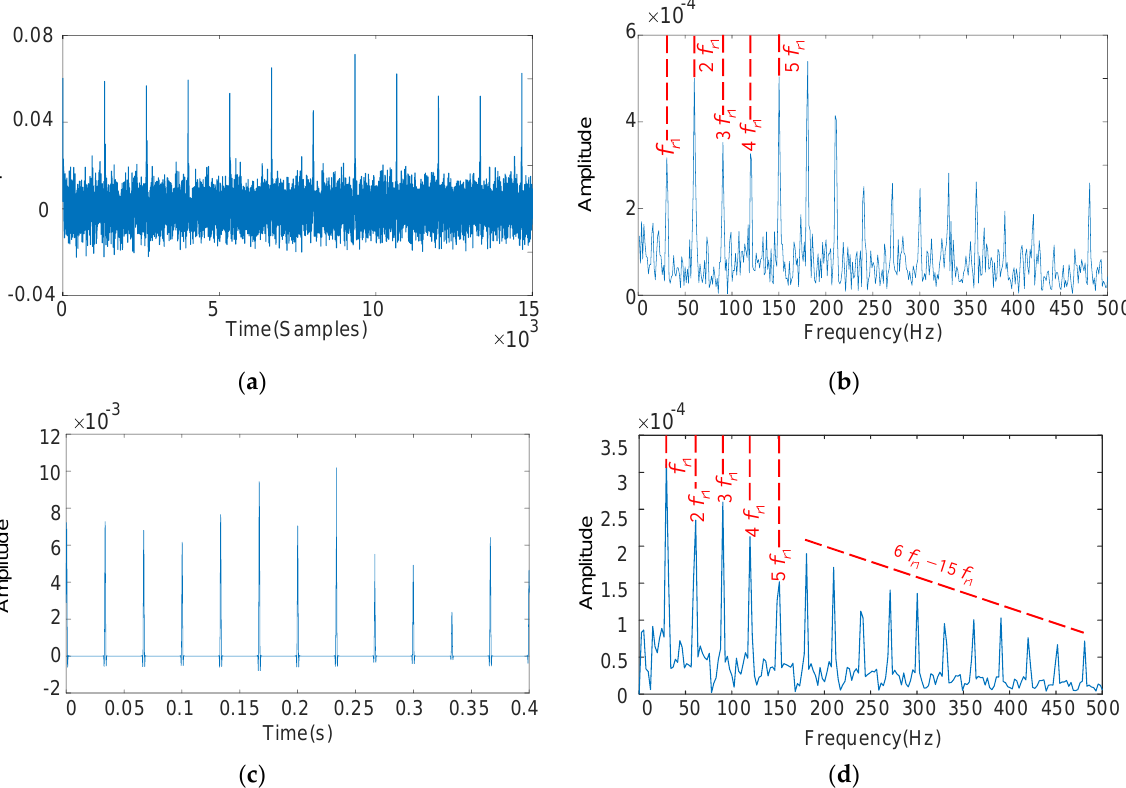
Figure 7. The decoupled pinion vibration signal and its frequency spectrum: deconvolution results of MOMEDA: filtered time domain waveforms and their frequency spectrum ( a , b ); Results obtained by MOMEDA and optimized RSSD: time domain waveforms and their frequency spectrum ( c , d ). The deconvolution period T r 2 is set with the fault characteristics of the IMS gear, and the results as shown in Figure 8. Periodic pulses can be seen in Figure 8a, and the rest of the fault characteristics are not apparent except for 4 f r 2 in Figure 8b, but 4 f r 2 is easily confused with the HSS pinion fault characteristic frequency f r 1 , leading to misdiagnosis. The optimized parameters are: Q H = 4.0, Q L = 1.2, r H = 5.0, r L = 3.5, and the low-resonance components obtained by decomposition are shown in Figure 8c,d. The interference com- ponents are reduced in the time domain diagram, and the IMS gear fault characteristic frequency f r 2 and its multiples 2 f r 2 –6 f r 2 predominate in the envelope spectrum.